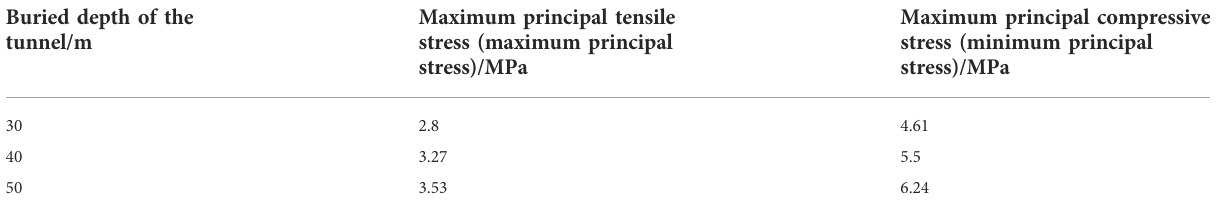
TABLE 7 Maximum and minimum principal stress of a research section with different burial depths. Buried depth of the